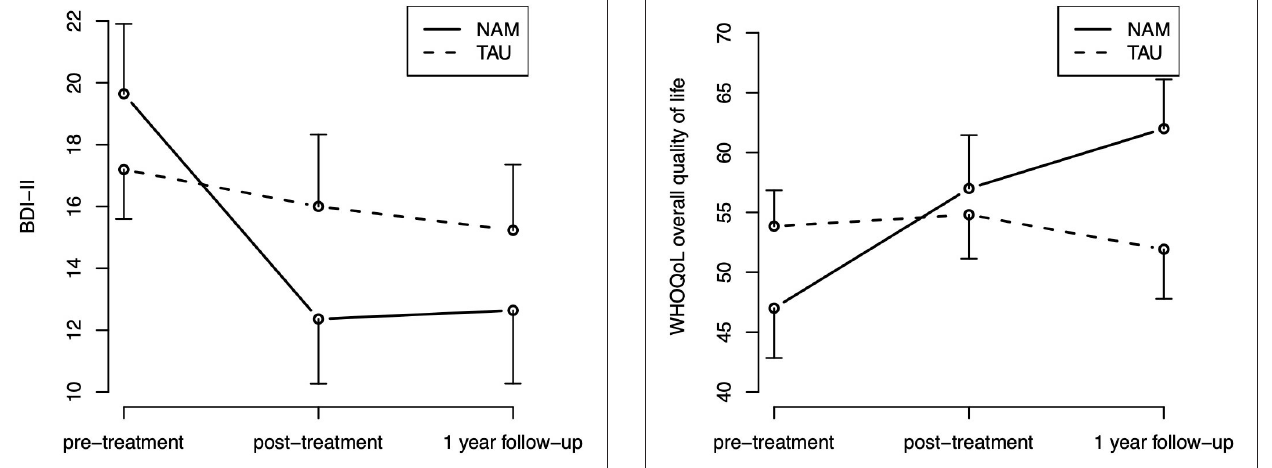
FIGURE 4 | Overall quality of life (WHOQOL) time course by treatment group (means and standard